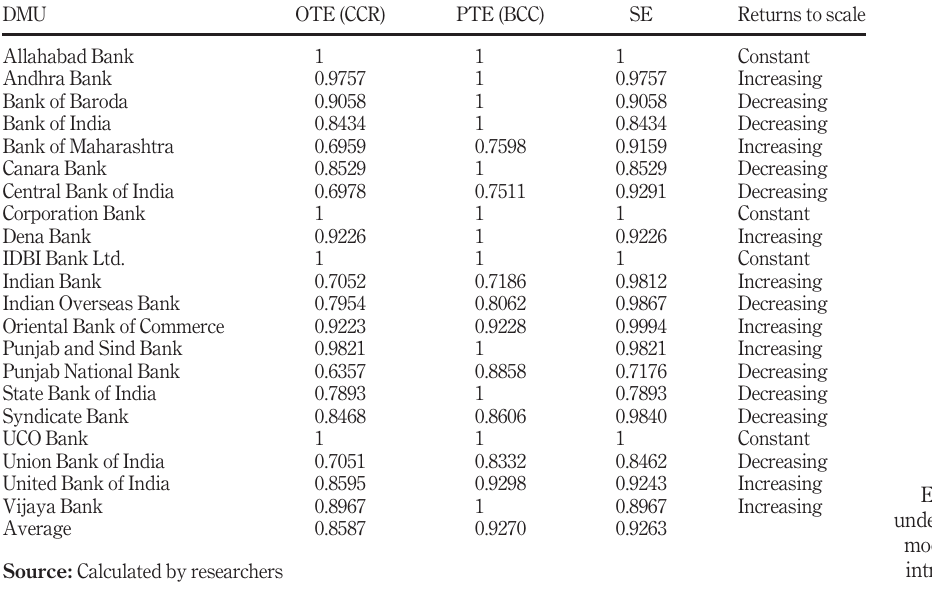
Table 3. Ef fi ciency